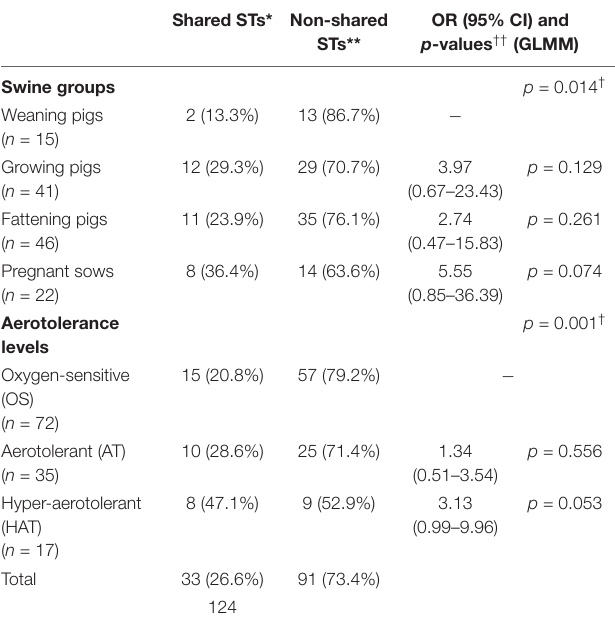
TABLE 4 | Campylobacter coli in the shared multilocus sequence typing (MLST) sequence types (STs) with human C. coli isolates (PubMLST) according to the swine groups and aerotolerance levels of C. coli